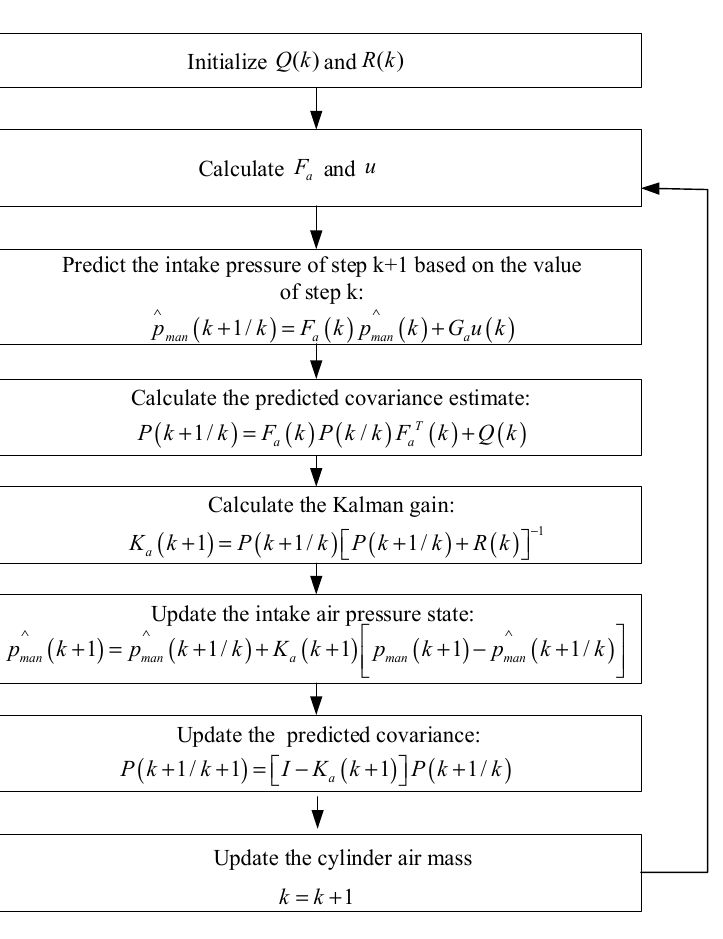
Figure 7. The calculating steps of the intake air observer.